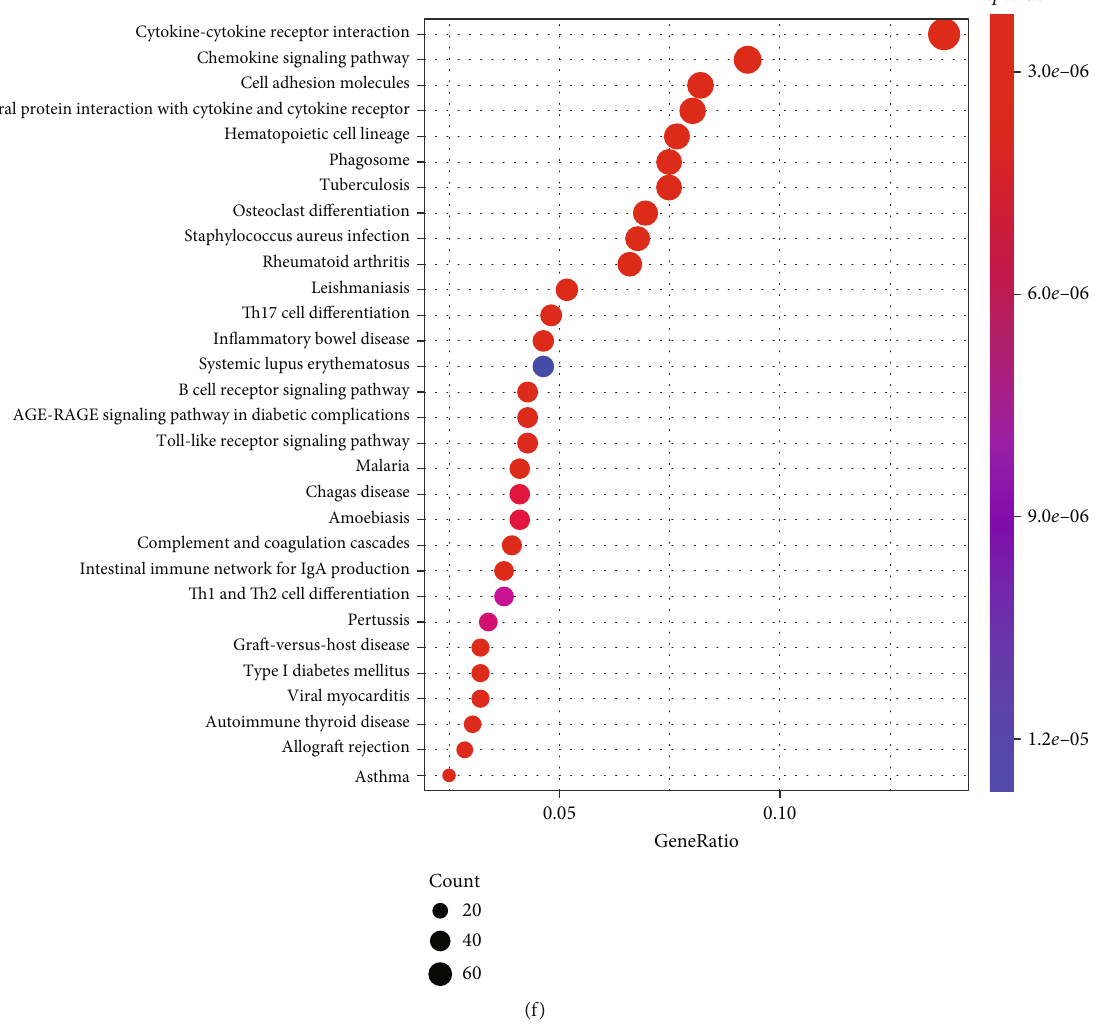
Figure 3: DEGs shared by the StromalScore and ImmuneScore and functional enrichment investigation. (a) The heat map of DEGs obtained in accordance with the ImmuneScore. (b) The heat map of DEGs obtained in accordance with the StromalScore. (c, d) Venn plots showing common increased and reduced DEGs shared by the ImmuneScore and StromalScore. (e, f) GO and KEGG assays with the use of the above